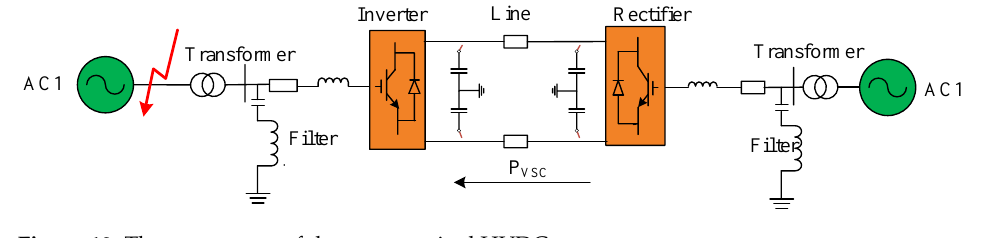
Figure 10. The test system of the two-terminal HVDC. Table 1. The control modes of each converter. Table 1. The control modes of each converter.